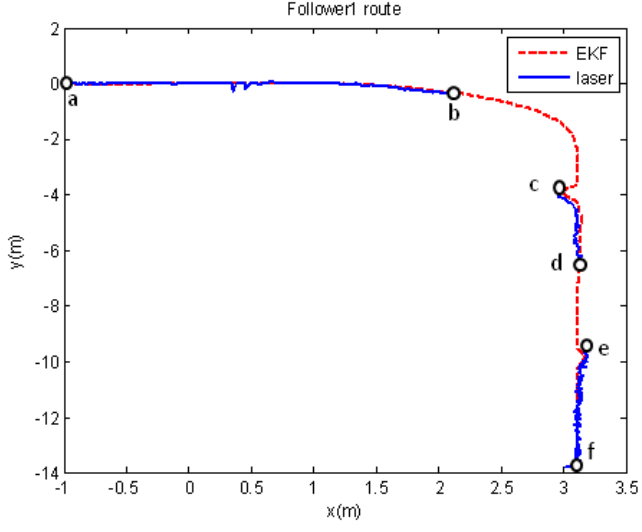
Figure 10. Path pursuit by the follower unit using the discrete EKF fusion proposal as part of the high level control. The blue plot shows the position information registered by the laser scanner, and the red one the location estimated by the EKF. The laser scanner is only available in intervals “ ab ”, “ cd ” and “ ef